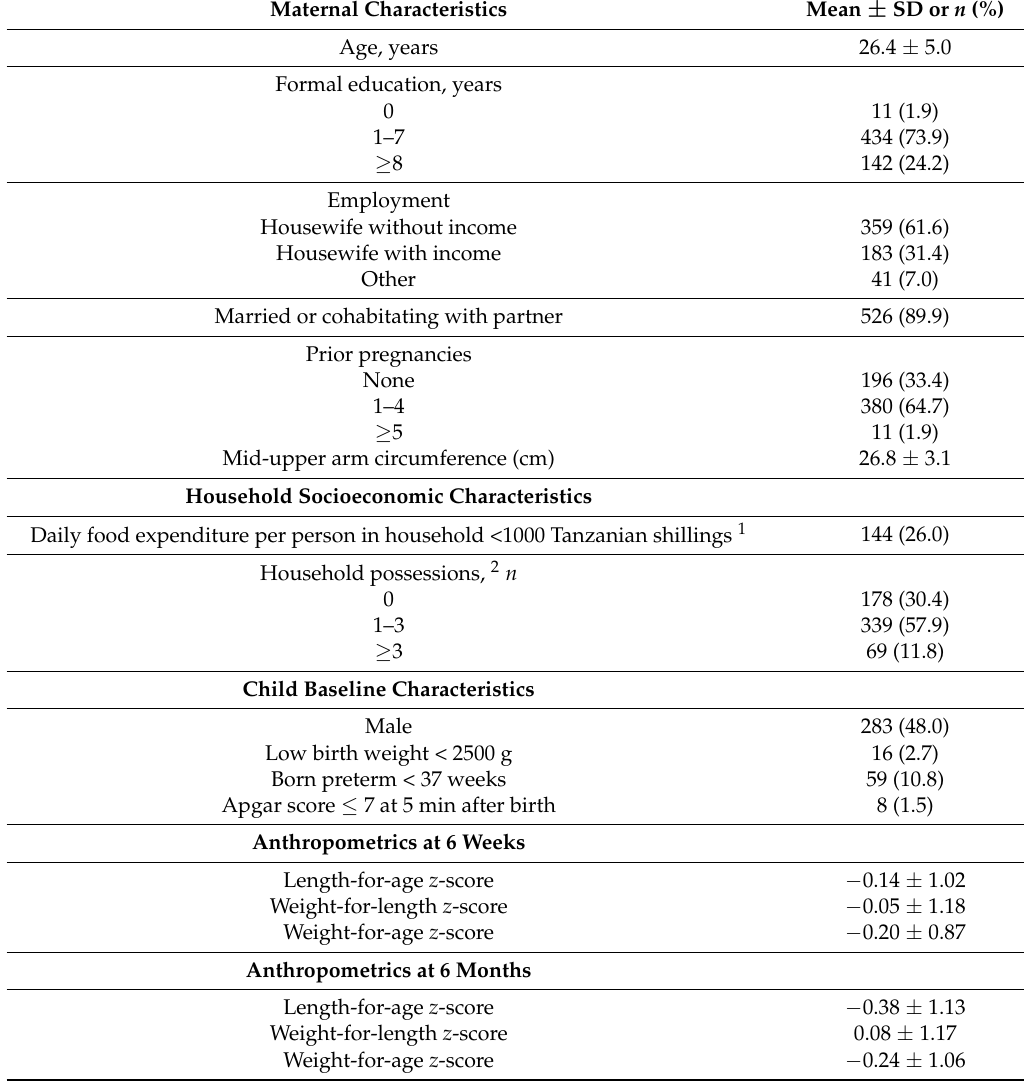
Table 1. Baseline maternal and child characteristics, n =